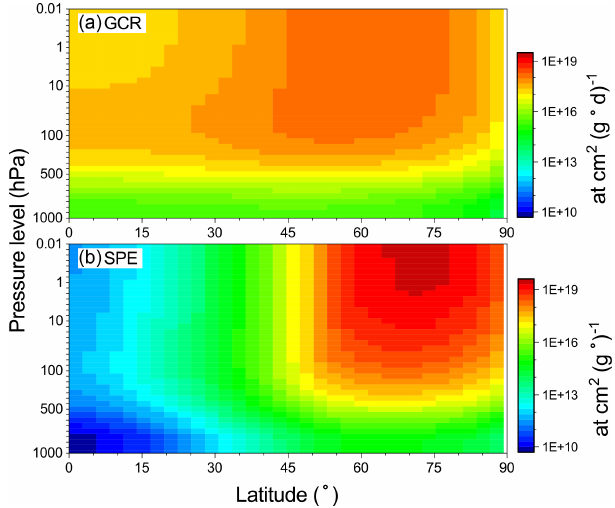
Figure 3. Zonal mean production of 7 Be in the Northern Hemi- sphere as a function of geographical latitude and the model’s atmo- spheric pressure level. (a) Daily production by GCRs averaged over the period of 2002–2008. The color scale (on the right) is given in units of atoms per day per degree of latitude per gram per square centimeter (gcm − 2 ). (b) Total production by SPE on 20 January 2005. The color scale is in units of atoms per degree of latitude per gram per square centimeter (gcm − 2